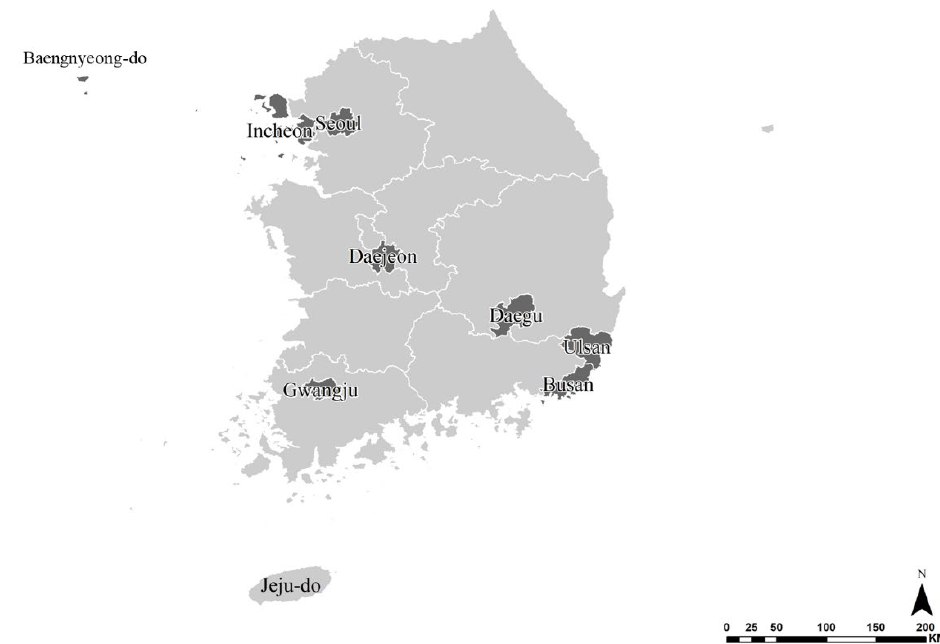
Figure 1. Research subject: Seven megacities in South Korea.